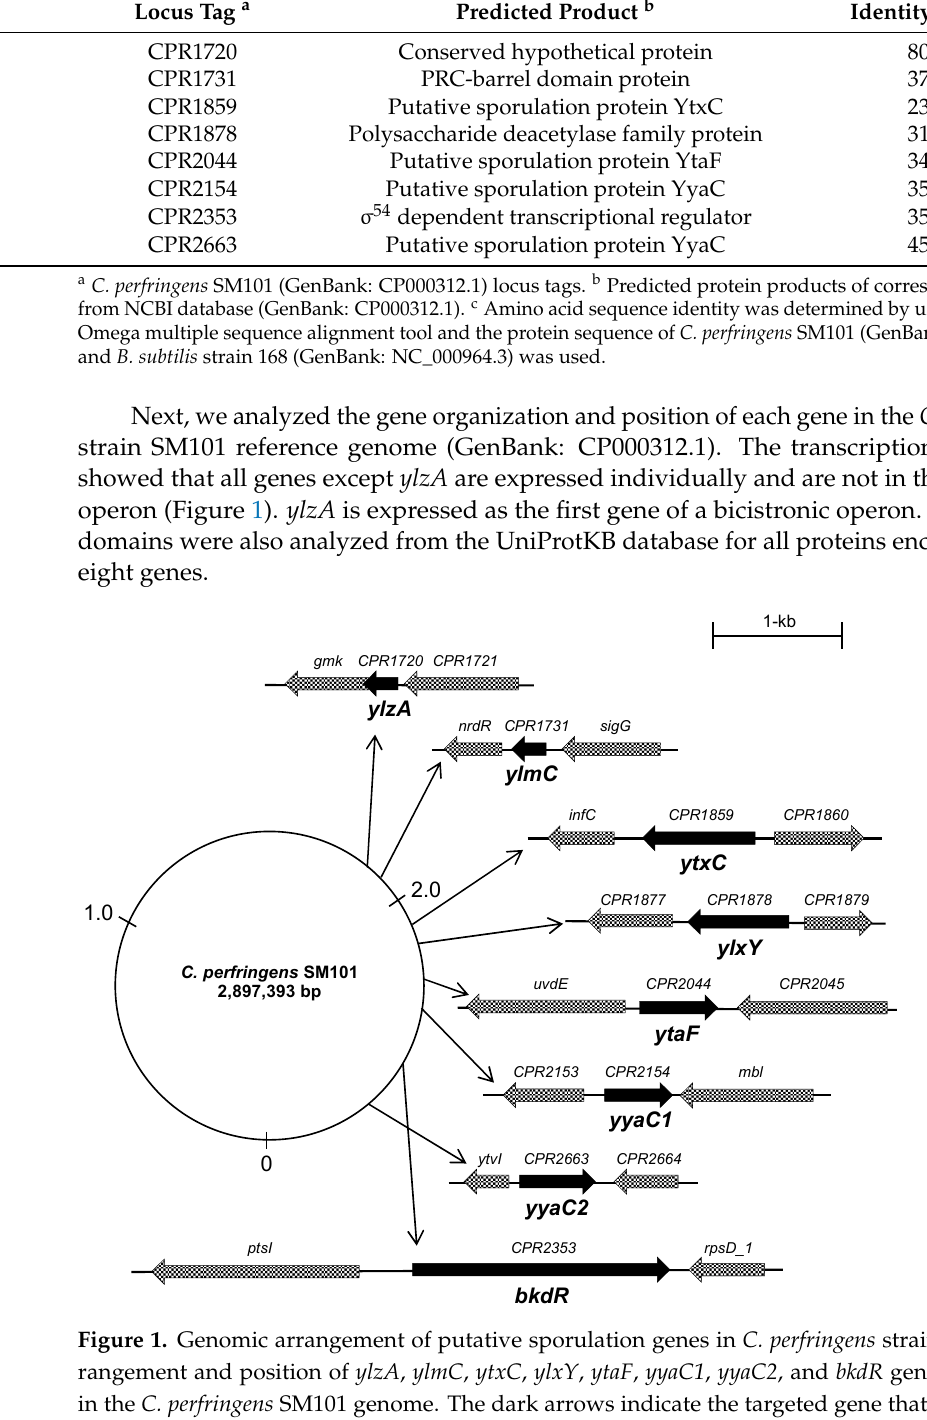
Table 1. Putative sporulation genes in C. perfringens strain SM101.P.